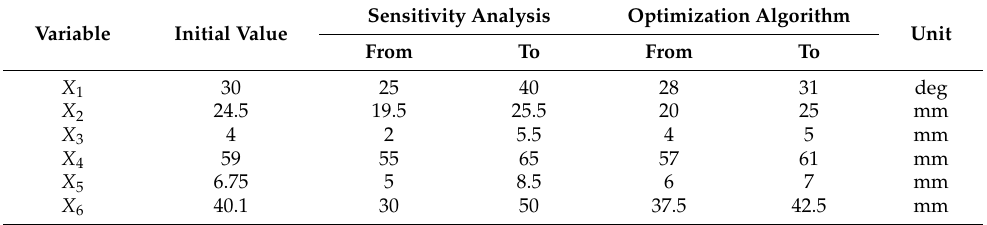
Table 3. Variation interval of the rotor parameters for the sensitivity analysis and optimization